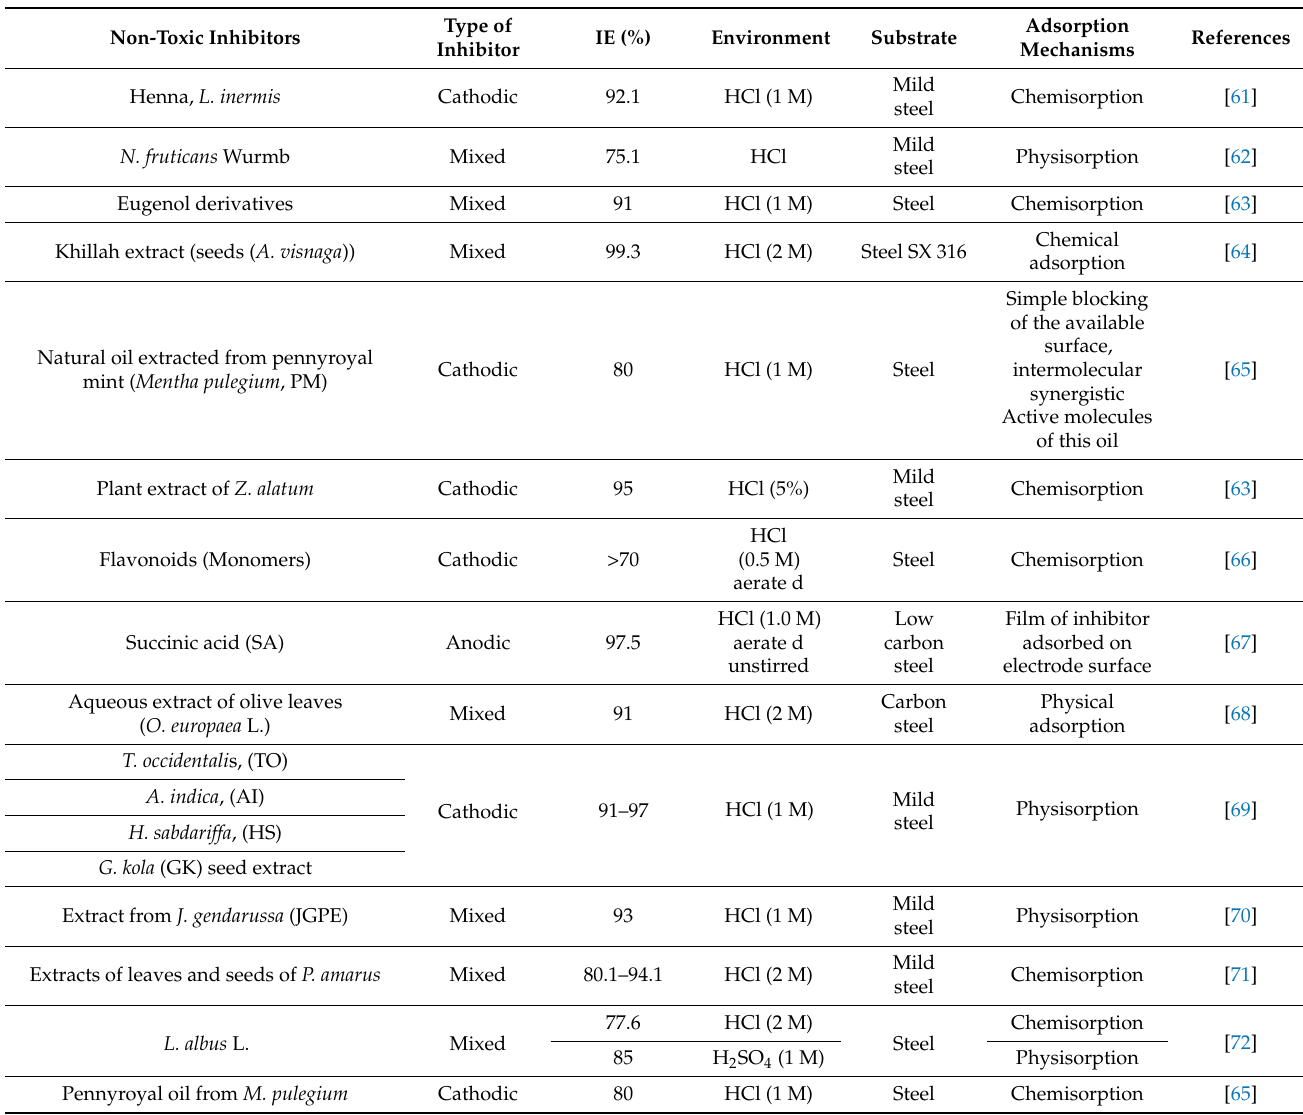
Table 3. Literature review on the use of natural substances as corrosion